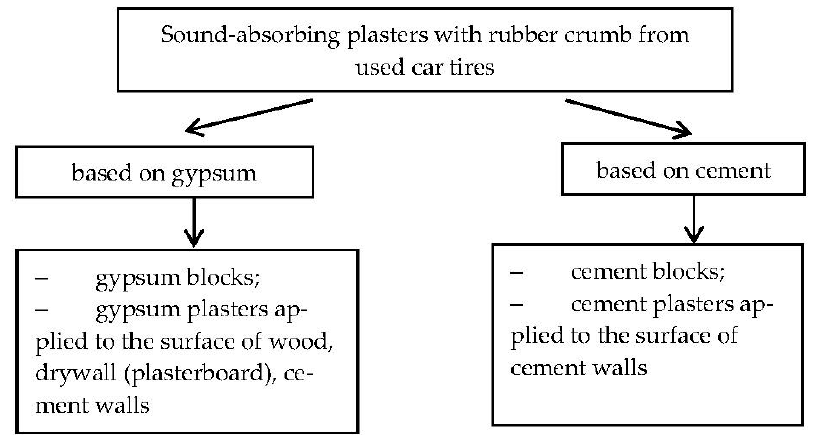
Figure 2. Possible combinations of sound-absorbing plaster and base